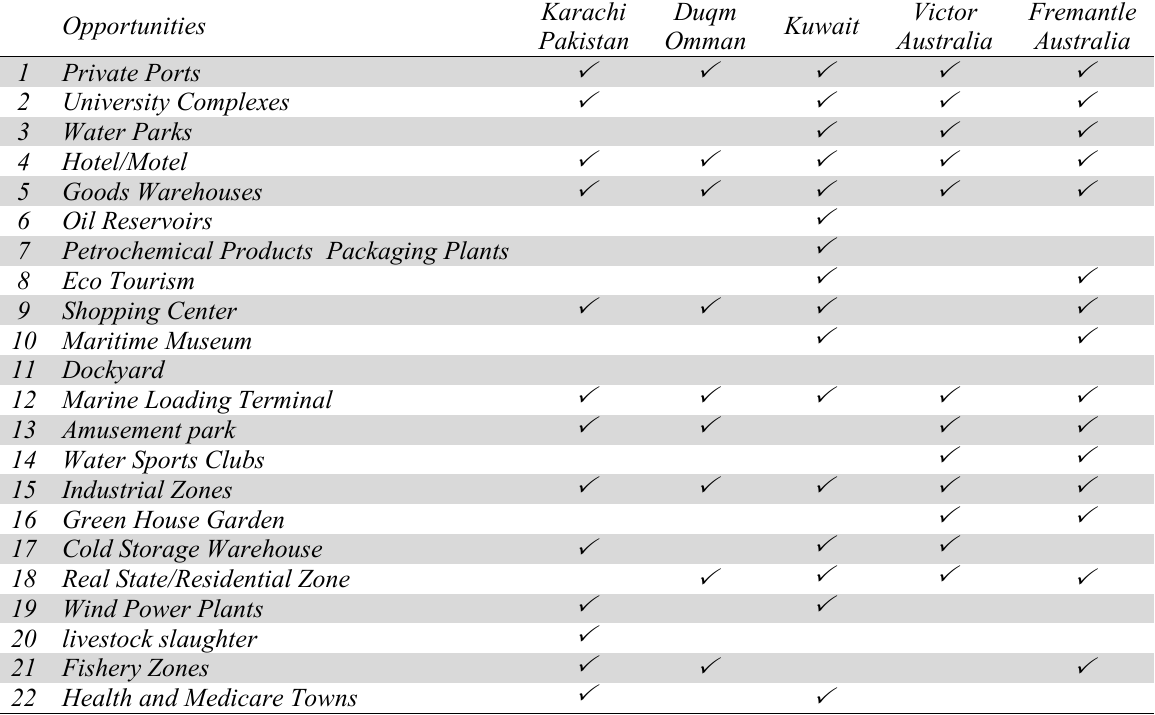
Investment opportunities 5 Port in Asia and the